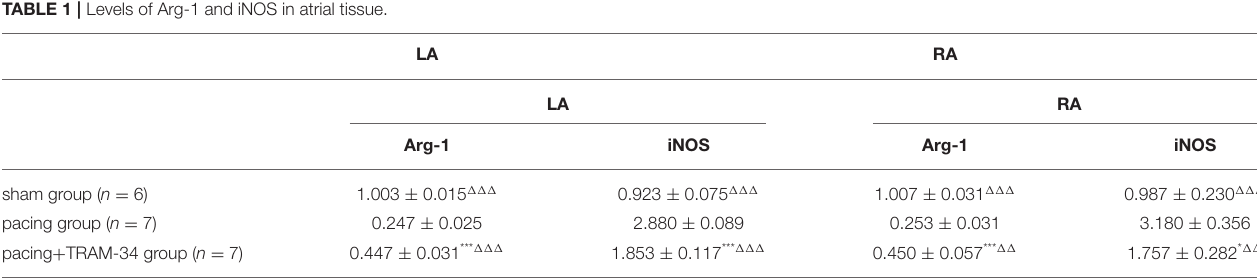
Figure 2 . The result provided a demonstration of the following: (1) both CD68-labeled macrophage and the expression of KCa3.1 in macrophage were elevated in the pacing group and inhibited by TRAM-34 ( P < 0.05). (2) in addition to macrophages, KCa3.1 is also widely expressed in cardiomyocytes. And the overall expression level of KCA3.1 in atria (mainly in cardiomyocytes according to the immunofluorescence figure) increased after atrial pacing. The expression of KCa3.1 protein in the LA and RA was compared in the sham, pacing, and pacing + TRAM-34 groups by Western blotting, as displayed in Figure 2 , its expression higher in the pacing group than in the control group (LA: 0.510 ± 0.062 vs. 0.115 ± 0.039, P < 0.001; RA: 0.543 ± 0.036 vs. 0.096 ± 0.041; P < 0.001), which was reduced by TRAM-34 treatment (LA: 0.543 ± 0.036 vs. 0.096 ± 0.041; P < 0.01; RA: 0.543 ± 0.036 vs. 0.214 ± 0.030; P < 0.01). There was no significant difference in the expression of KCa3.1 between the LA and the RA for any of the three groups, respectively. Western blotting also demonstrated that the concentration of CD68 was significantly higher in the pacing group than in the sham group which was reduced by treatment with TRAM-34. In addition, the concentration of atrial CD68 was higher in the pacing + TRAM-34 group than in the sham group. Quantification of Arg-1 and iNOS expression was determined by real time PCR for clarification purposes. As shown in Table 1 , the relative levels of Arg-1 mRNA in the atria were substantially lower in the pacing group than in the sham group, which was reduced by treatment with TRAM-34. The pacing + TRAM-34 group had a lower level of Arg-1 mRNA in the atria compared with the sham group.